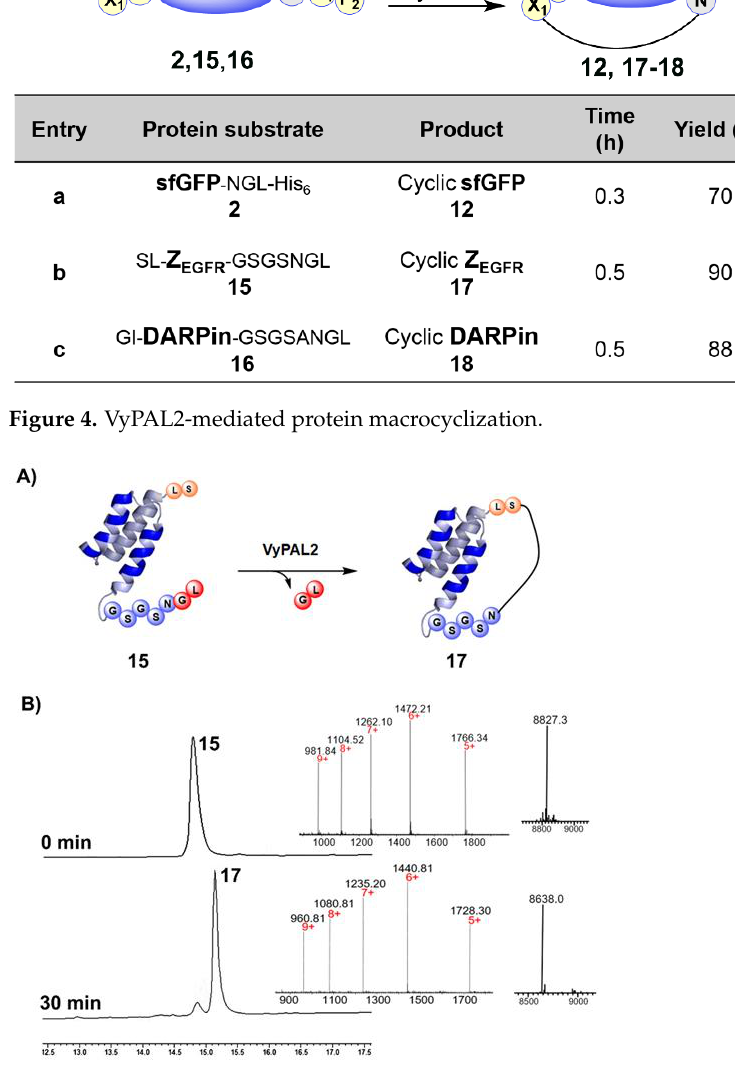
Figure 5. VyPAL-mediated macrocyclization of an EGFR-targeting affibody 15 . ( A ) Scheme